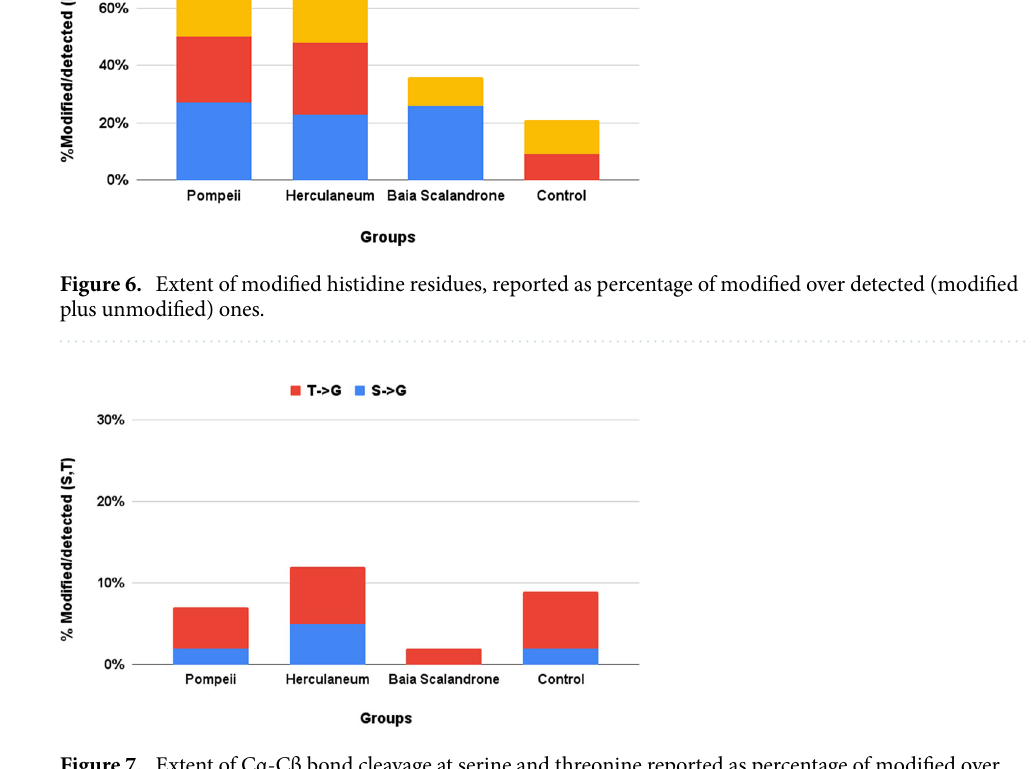
Figure 7. Extent of Cα-Cβ bond cleavage at serine and threonine reported as percentage of modified over detected (modified plus unmodified)